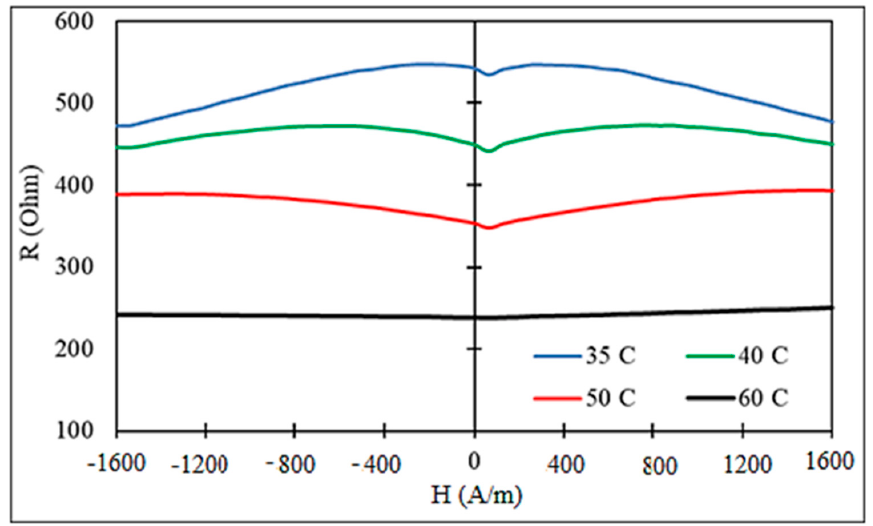
Figure 19. Real part of the impedance of glass-coated microwires of the composition Fe 3.9 Co 64.82 B 10.2 Si 12 Cr 9 Mo 0.08 having 𝑇 (cid:3030) = 61 ℃ for various temperatures. Frequency is 300 MHz.